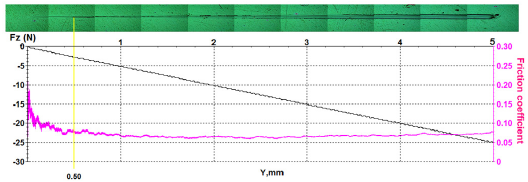
Figure 5. Friction coefficient (pink) and applied load (black) as a function of track distance obtained for scratching test for sample 3.